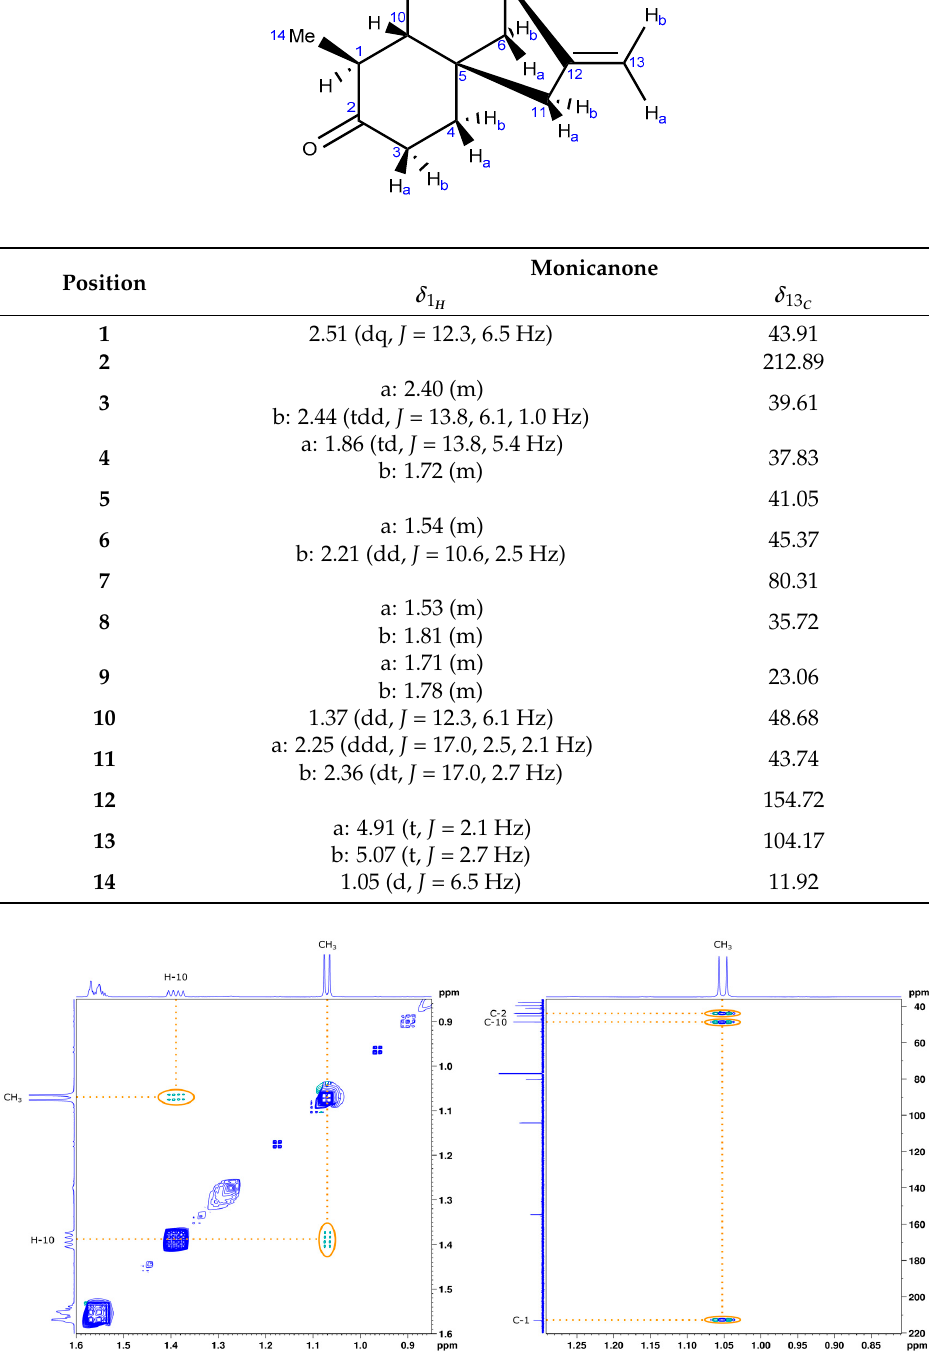
Figure 1. Zoom of the NOESY (left) and HMBC (right) spectrum of monicanone in CDCl 3 . Full spectra are available in Supplementary Materials S1 pages